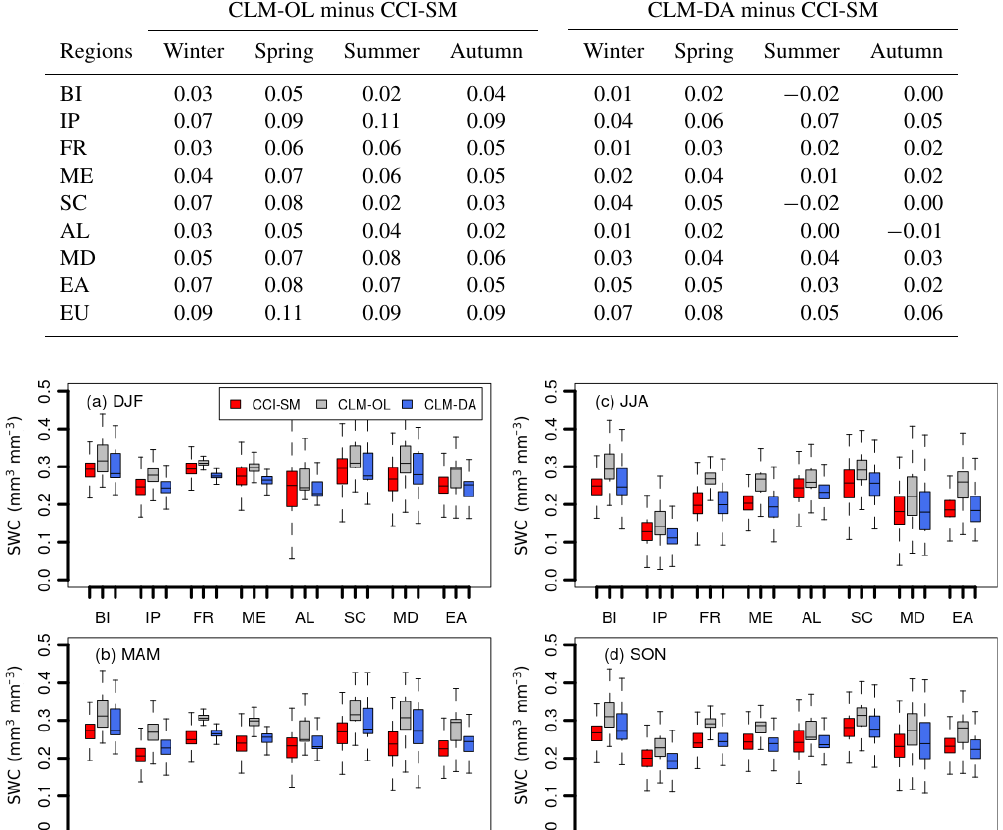
Table 1. Difference in CLM-OL and CLM-DA simulated mean seasonal SWC (mm 3 mm − 3 ) with CCI-SM data for all PRUDENCE regions and all seasons, i.e., winter (DJF), spring (MAM), summer (JJA) and autumn (SON).